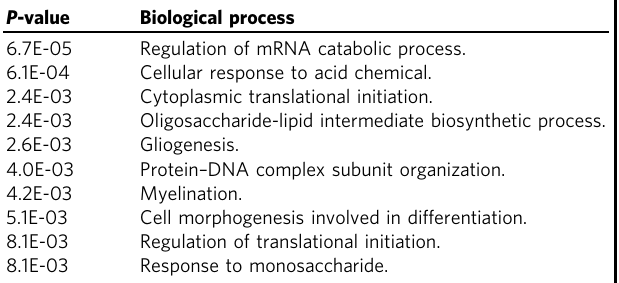
Table 2 Top biological processes enriched for genes that display upregulation of IPA isoforms in TB differentiation from hESCs.